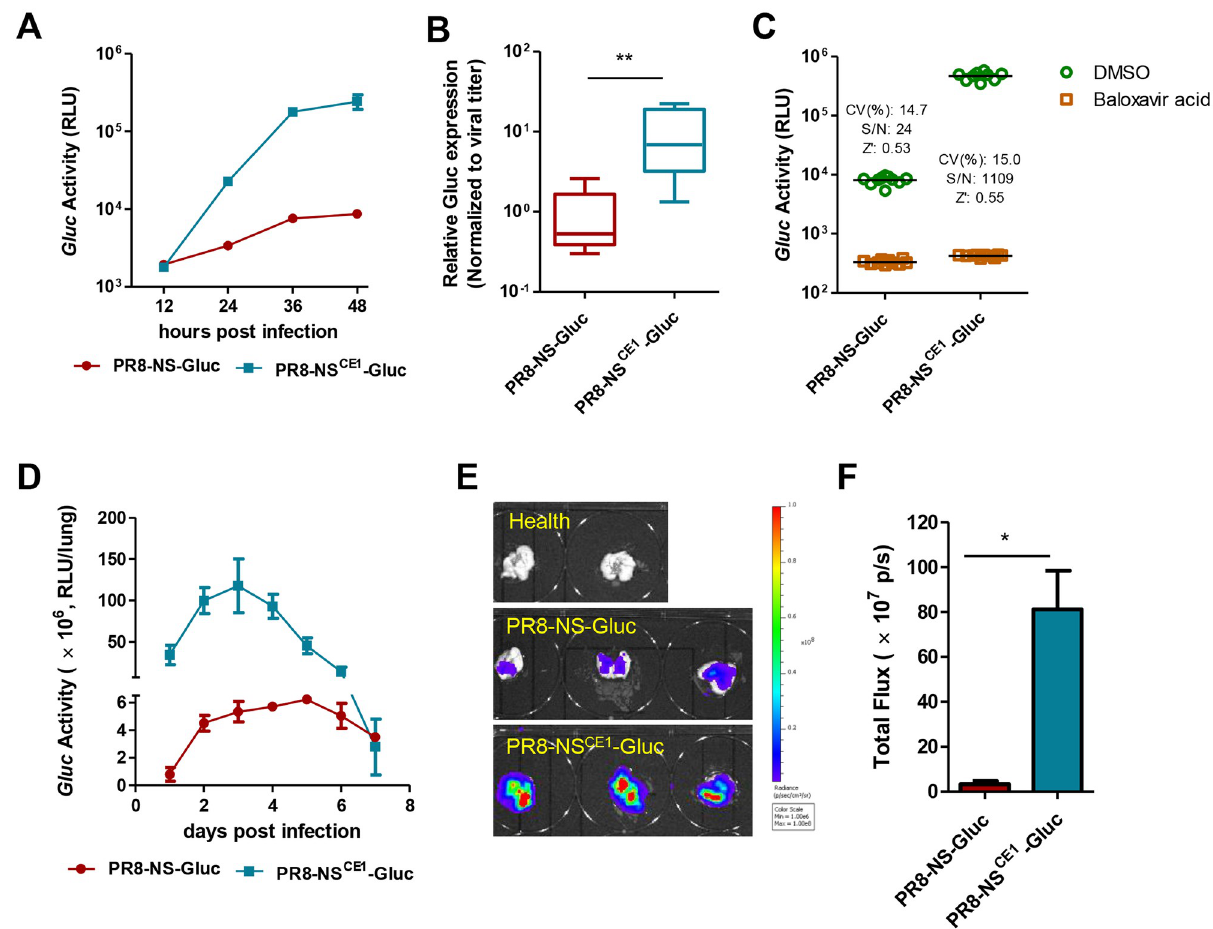
Fig 3. Compensatory enhancement augments the expression of reporter genes. (A) Kinetics of reporter luciferase expression during virus replication in vitro . (B) Normalized Gluc activity to virus titers of identical time points (relative Gluc activity/viral titer) for original PR8-NS-Gluc and mutated PR8-NS CE1 -Gluc viruses. (C) Adaptation of the reporter viruses as an in vitro high-throughput screening approach. CV, coefficient of variation; S/N, signal-to-noise ratio. (D) Kinetics of reporter luciferase expression during virus replication in mice. (E) Ex-vivo imaging of excised mice lungs. (F) The signals of ex-vivo imaging derived from mice lungs infected by reporter PR8-NS-Gluc and PR8-NS CE1 -Gluc viruses.